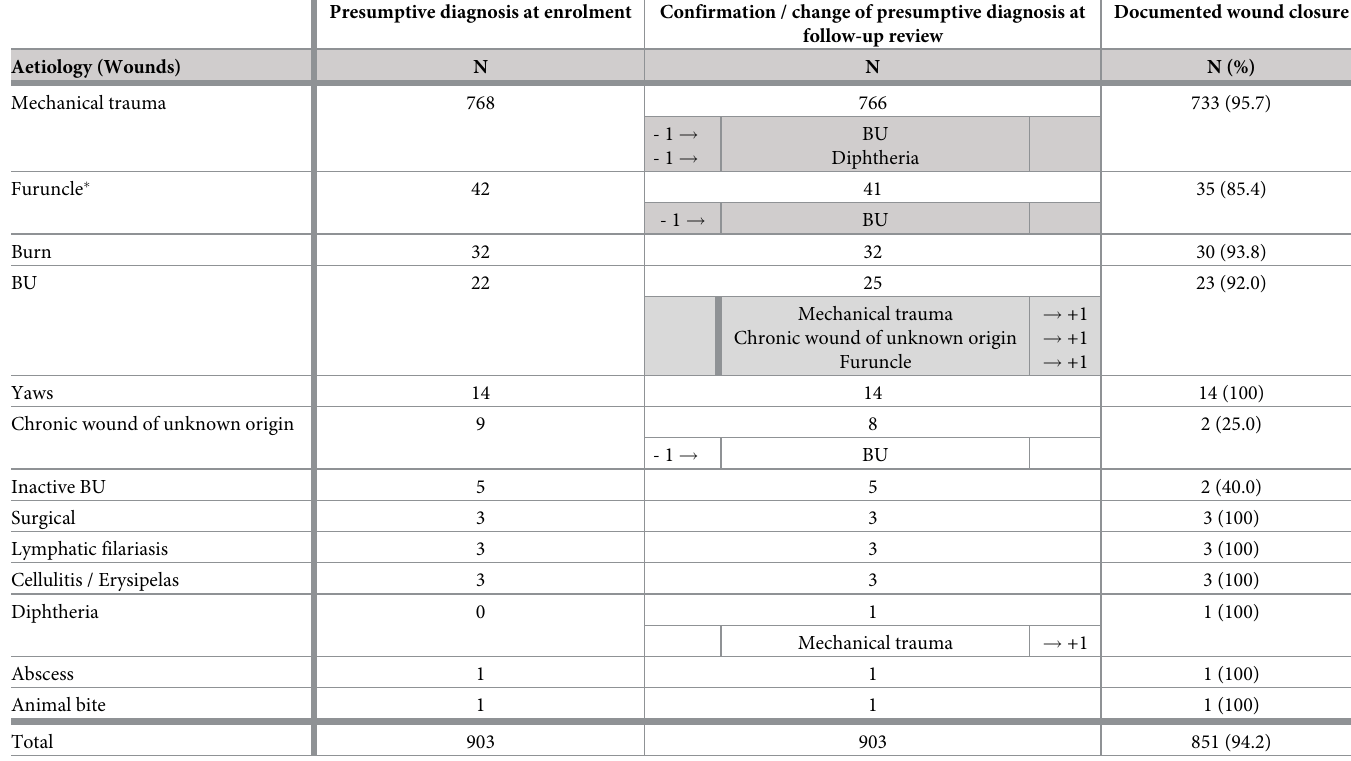
Table 3. Distribution of wound aetiology, presumptive clinical diagnosis at enrolment and confirmation. Presumptive diagnosis at